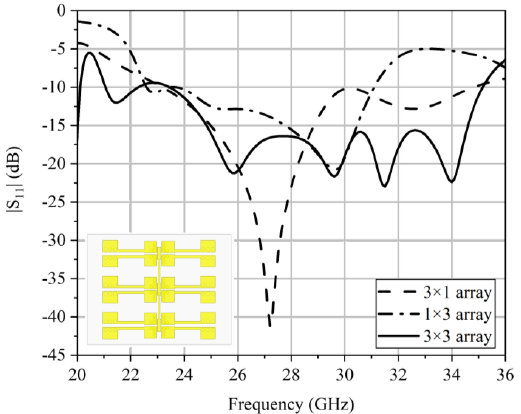
Figure 8. Simulated |S 11 | of the 1-D 3 × 1 interconnected ME dipole array along the x-direction, 1-D 1 × 3 interconnected ME dipole array along the y-direction and the 2-D 3 × 3 interconnected ME dipole array.